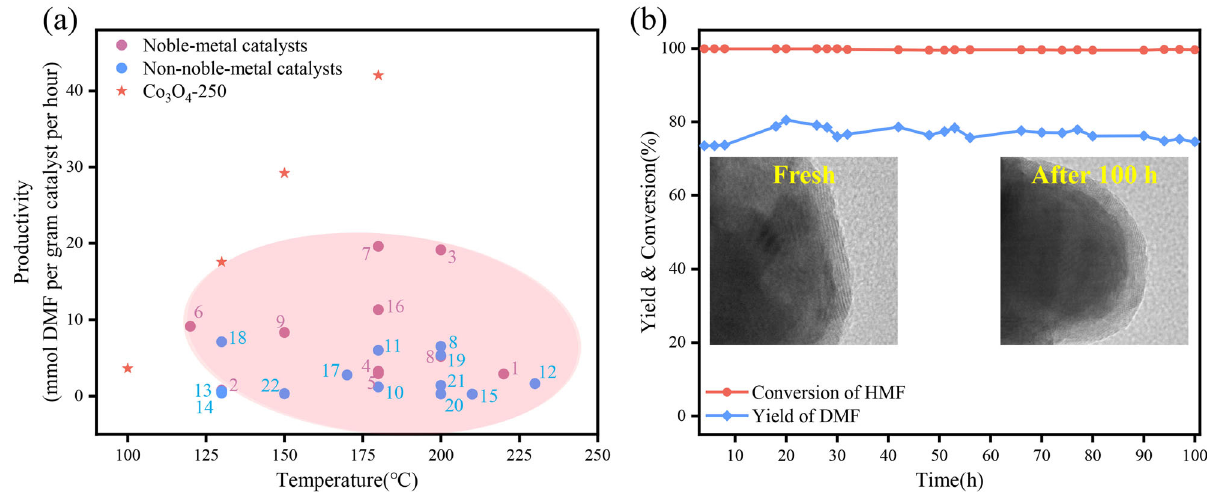
Fig. 2 Catalytic performance of Co 3 O 4 -250 in the hydrogenolysis of HMF to DMF. a Comparison of the catalytic performances of the state-of-the-art catalysts for the hydrogenolysis of HMF to DMF. A summary of the productivities of representative noble-metal catalysts (purple circles), non-noble-metal catalysts (blue circles), Co 3 O 4 -250. Full data is shown in Table S1. (1) Ru-doped hydrotalcite 25 ; (2) Ru/Co 3 O 4 7 ; (3) RuCo/CoO x 26 ; (4) Ru/CoFe-LDO 27 ; (5) Pt 1 /Co 28 ; (6) Pt/rGO 29 ; (7) PtCo@HCS 10 ; (8) Pd-OMD1/Ni-OMD1 30 ; (9) Pd/C/Zn 31 ; (10) Raney Co 32 ; (11) Ni/C 33 ; (12) Ni/LaFeO 3 34 ; (13) Ni-Co oxides 8 ; (14) Ni-Co/C 35 ; (15) 2%Ni-20%Co/C 36 ; (16) Ag-Co@C 37 ; (17) Co-CoO x 38 ; (18) Co/Mix-ZrO 2 39 ; (19) CuZn 40 ; (20) Cu-Ni/Al 2 O 3 41 ; (21) CuNi/